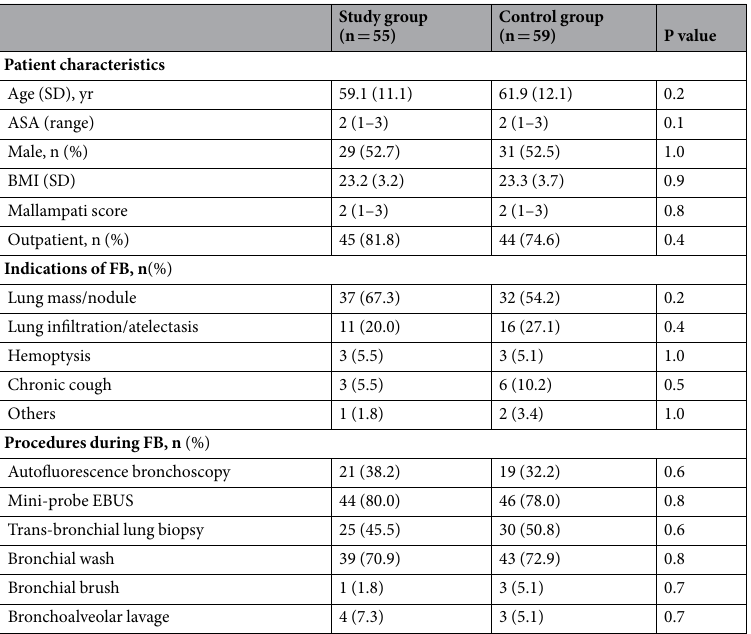
Table 1. Patient characteristics, indications for flexible bronchoscopy (FB), and procedures performed. Data are presented as mean ± standard deviation or number and percentage in parentheses. Abbreviations: ASA, American Society of Anesthesiologists; BMI, body mass index; FB: flexible bronchoscopy; EBUS, endobronchial